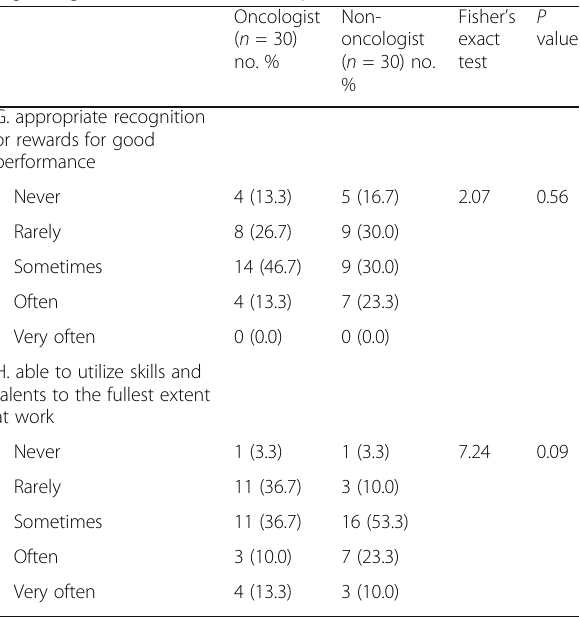
Table 5 Comparison between oncologist and non-oncologist regarding different items of work place stress scale